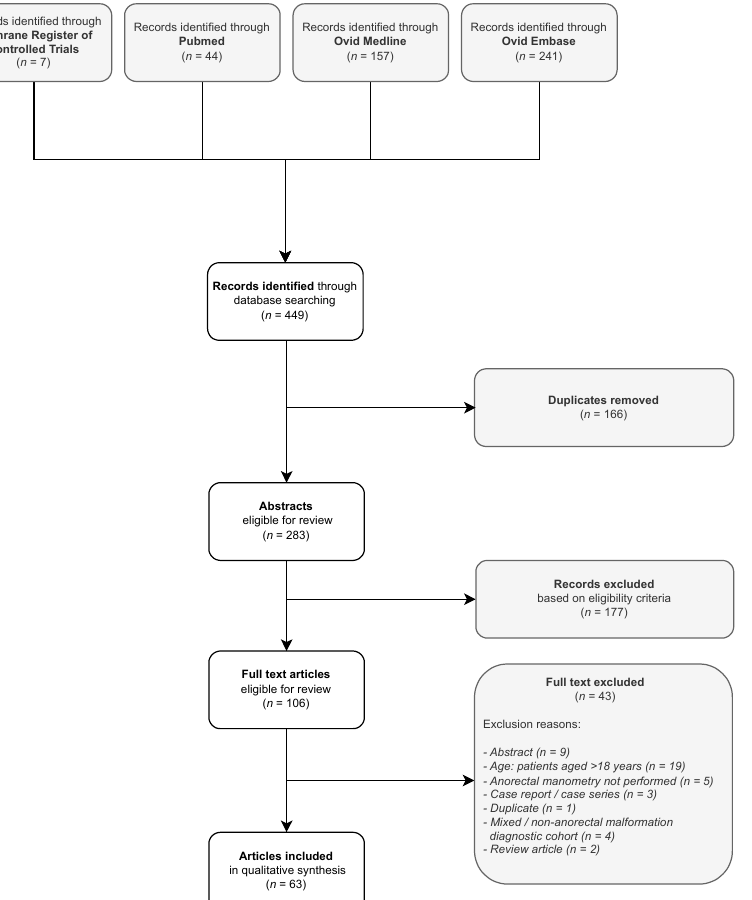
Figure 1. Study selection flow diagram.